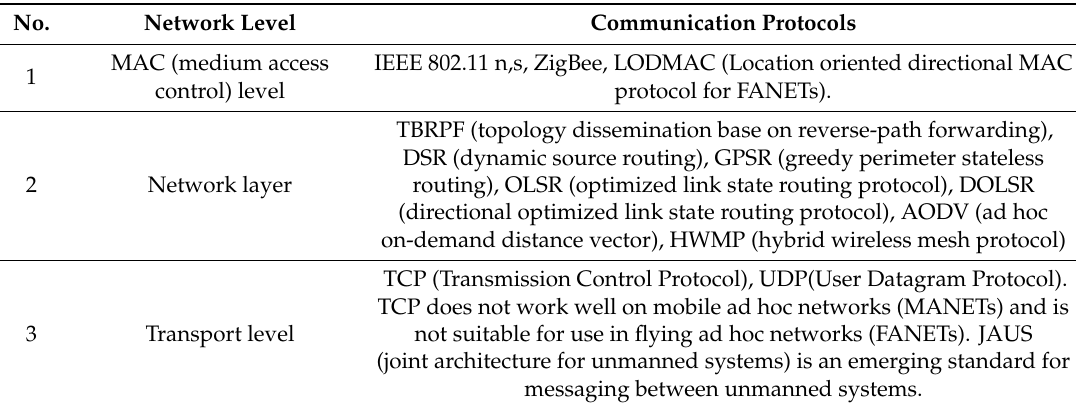
Table 2. Types of protocols for mobile networks.